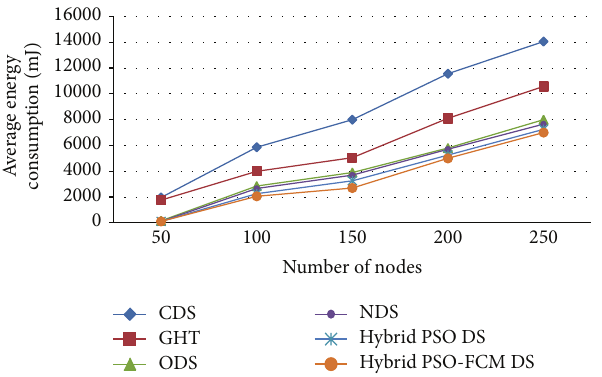
Figure 6: Network Lifetime with different number of storage nodes.